Question: Which visualization type does this figure use?
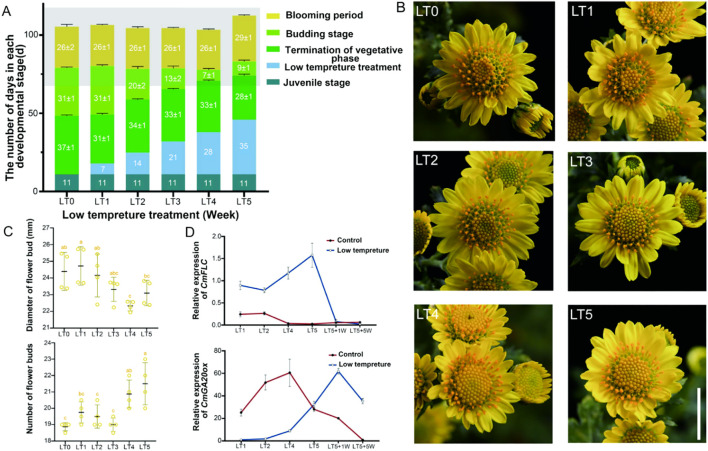
Answer: line